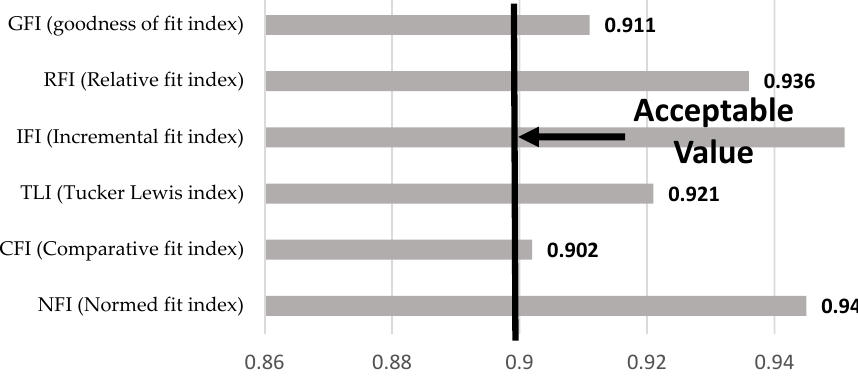
Table 8. Normality test.